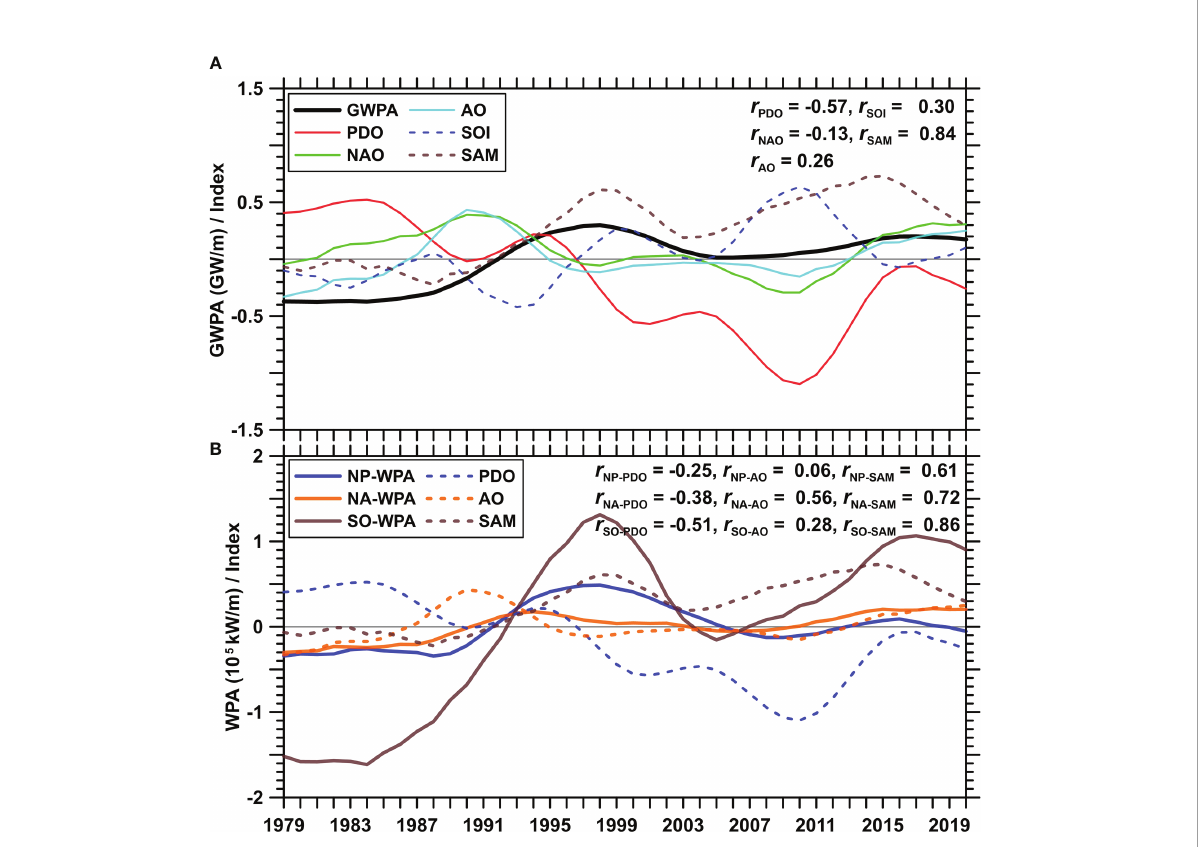
FIGURE 9 Time series of the wave power anomaly and the climate variability indexes (PDO, Paci fi c Decadal Oscillation; NAO, North Atlantic Oscillation; AO, Arctic Oscillation; SOI, Southern Oscillation Index; SAM, Southern Annular Mode). (A) For annual global wave power anomaly, (B) for wave power anomaly in the North Paci fi c (NP, 130°E~250°E), North Atlantic (NA, 310°E~360°E), and Southern Oceans (SO, 40°S~80°S). Their correlation coef fi cients are shown in the